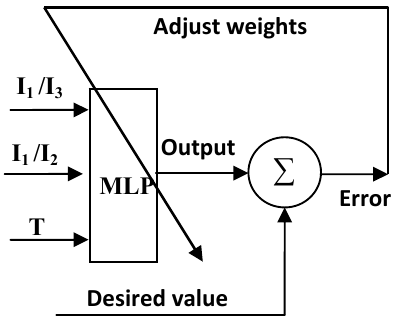
Figure 4. MLP-based wavelength readout (training set).